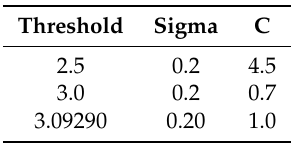
Table 5. Best parameter set found for the SVM and for each threshold.